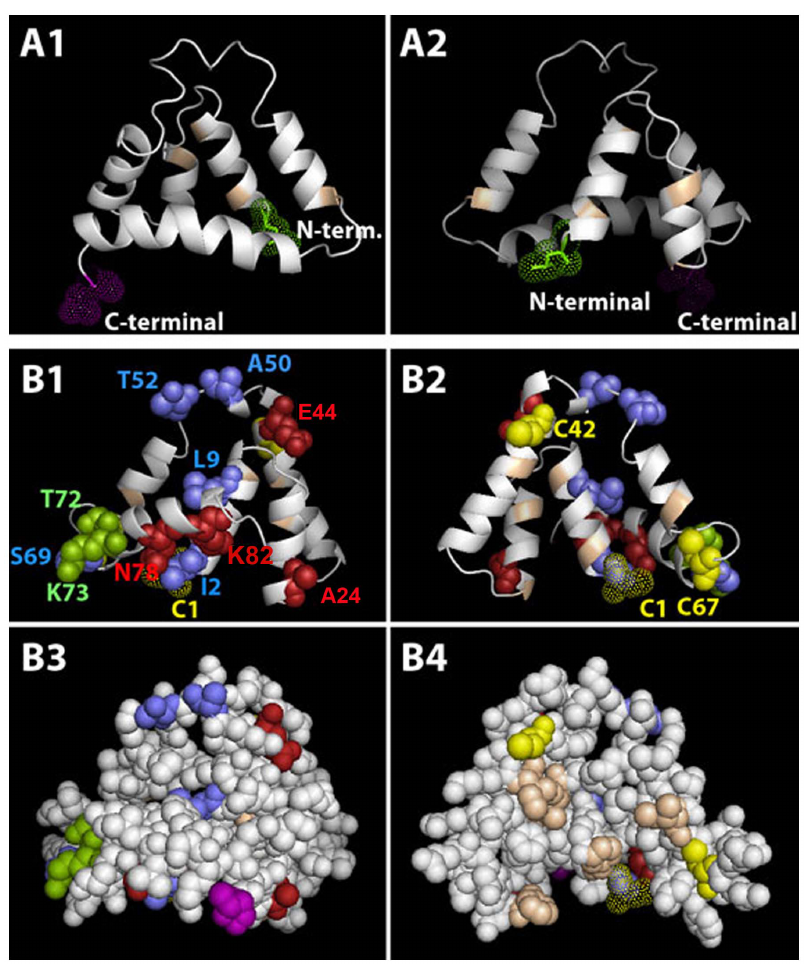
Fig. 2. Structures of the ABPBG10 subunit (panels A1–2) and of the ABPBG2 subunit (panels B1–4) threaded on model c2ejnB with sites of interest indicated. Panels A1, A2, B1, and B2 are in cartoon format with alpha helices represented by helical ribbons and loops as thinner connecting lines. Panels B3 and B4 are space-filling models with amino acid residues as filled spheres. The conserved residues involved in ligand binding and subunit coordination in the dimer [43] are colored tan and K -Cys residues are colored yellow. Panel A1 shows the exterior face of the ABPBG10 subunit and panel A2 shows its interior face (the N- terminal residue is in green dotted spheres and the C-terminal residue is in red dotted spheres). Panels B1–4 show residues under selection in the tear ABPBGs. Panels B1 and B3 are exterior views and panels B2 and B4 are interior views. Residues in red are selected with a BEB posterior probability of 99%; those in green with BEB posterior probabilities of 95%; and those in blue with a BEB posterior probability of 90% (the N-terminal K -Cys residue is a yellow dotted sphere; the C-terminal residue is